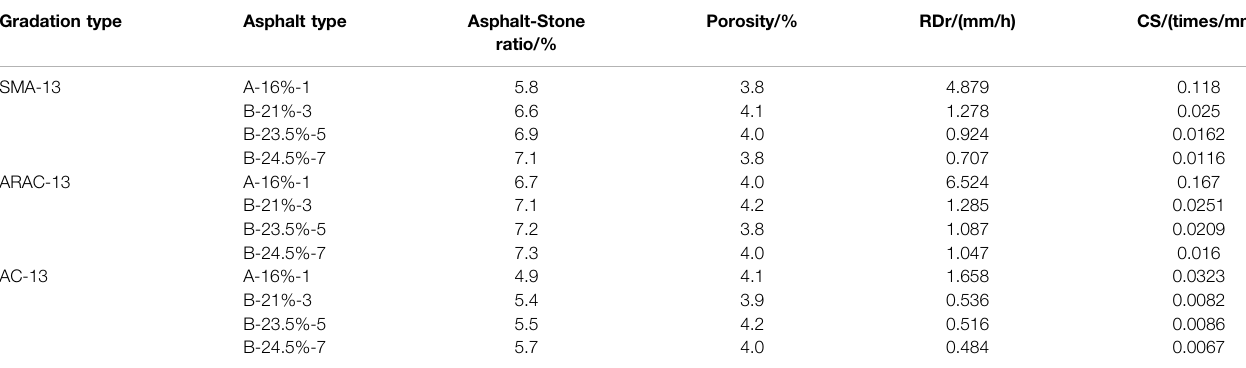
TABLE 5 | Asphalt-stone ratio and performance indexes of different modi fi ed asphalt